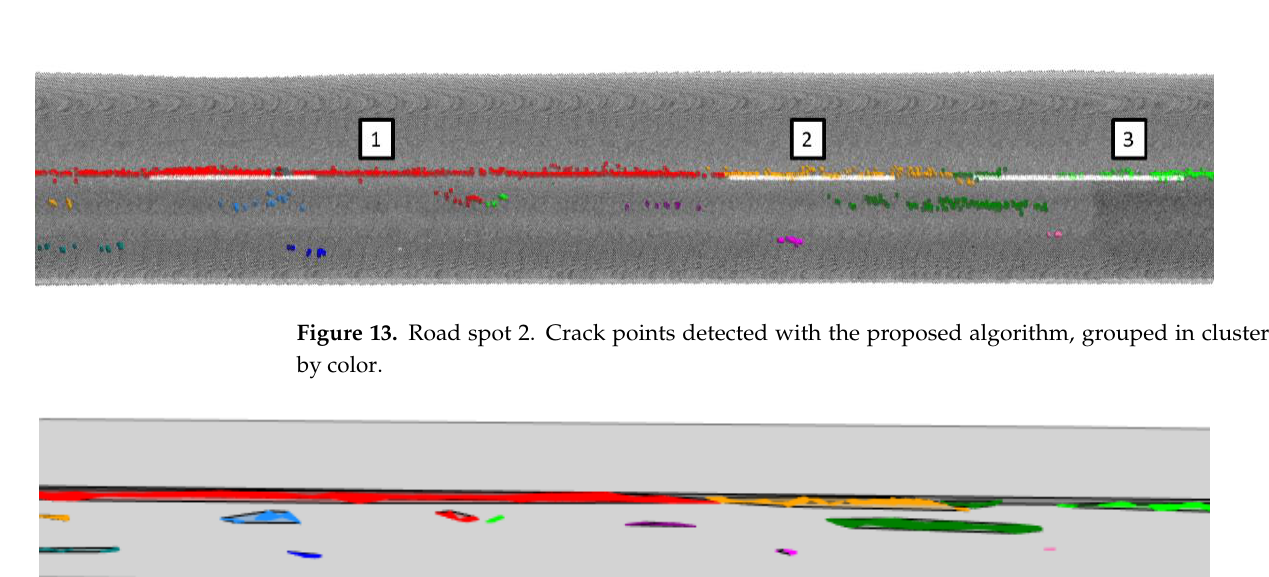
Figure 12. Road spot 2. Ladybug camera image with delimited cracked areas.